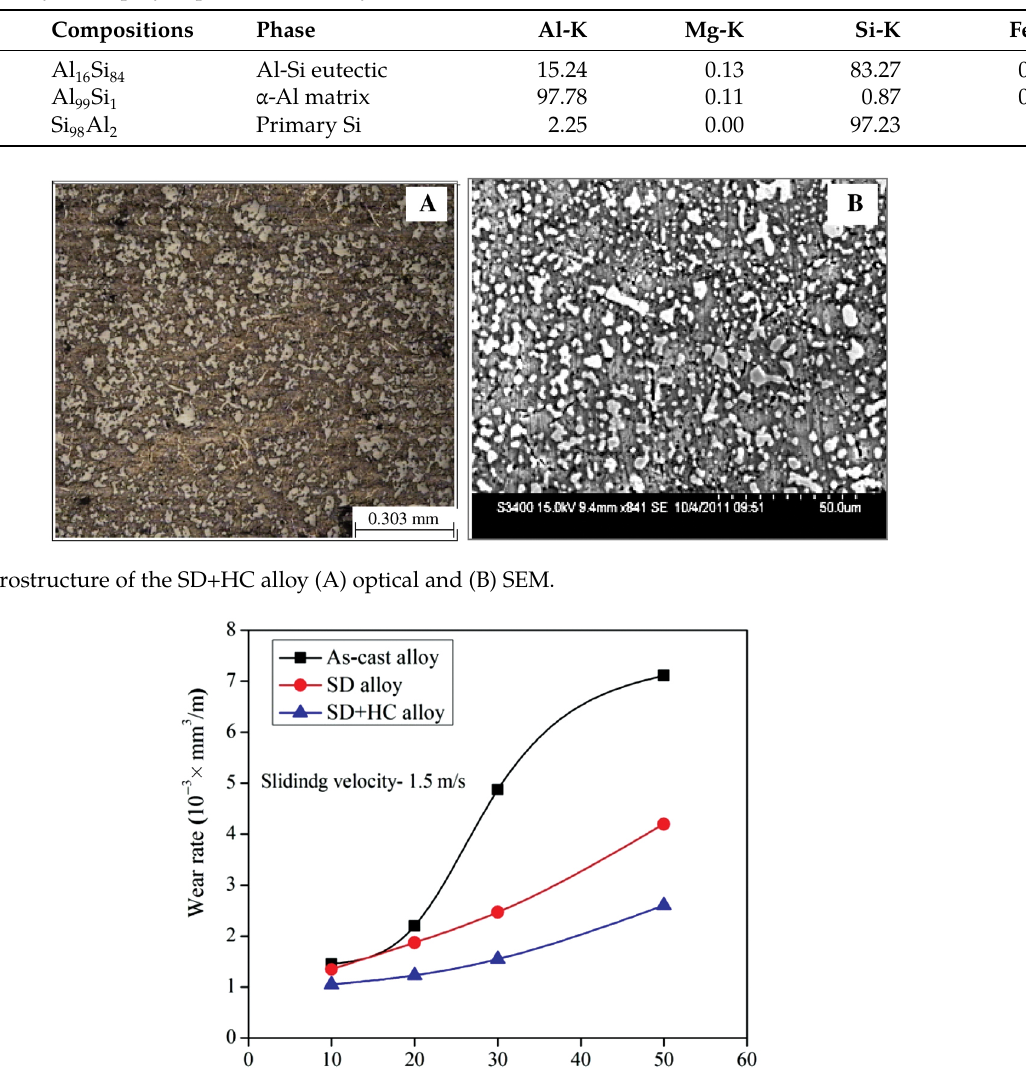
Table 4: EDS analysis of spray deposited (SD) alloy.